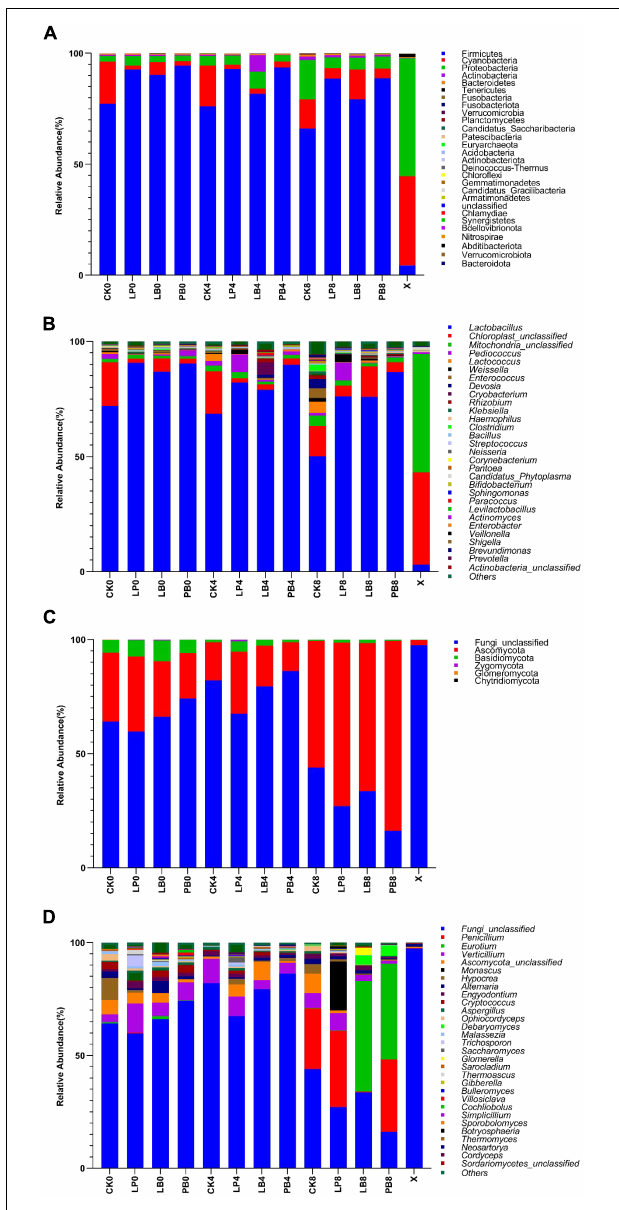
FIGURE 2 | Microbial community at the phylum-level (A,C) and genus-level (B,D) abundance changes during aerobic exposure of silage. CK, no additive control; LP, Lactobacillus plantarum ; LB, Lactobacillus buchneri ; PB, Lactobacillus plantarum + Lactobacillus buchneri ; X, fresh